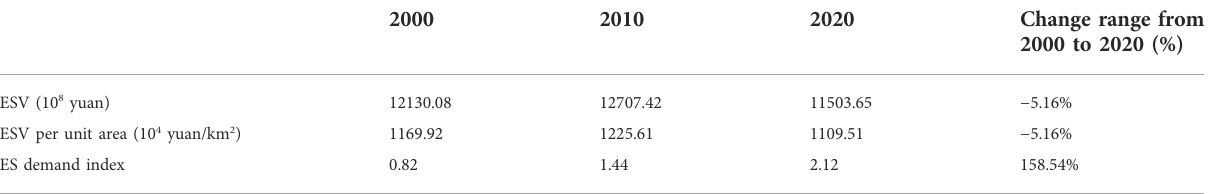
TABLE 5 Changes to the ecosystem service value and demand index in Jiangsu Province, from 2000 to 2020.